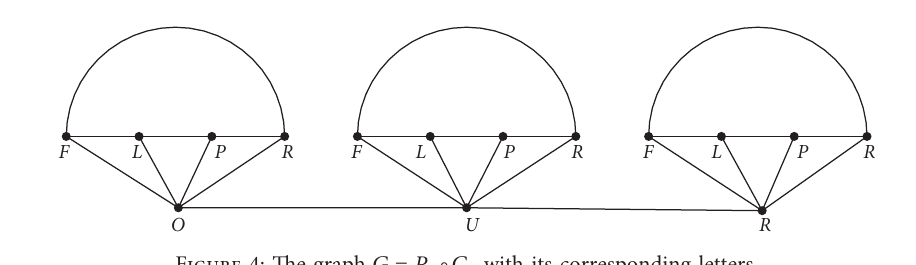
∘ C with its corresponding letters. 3 4